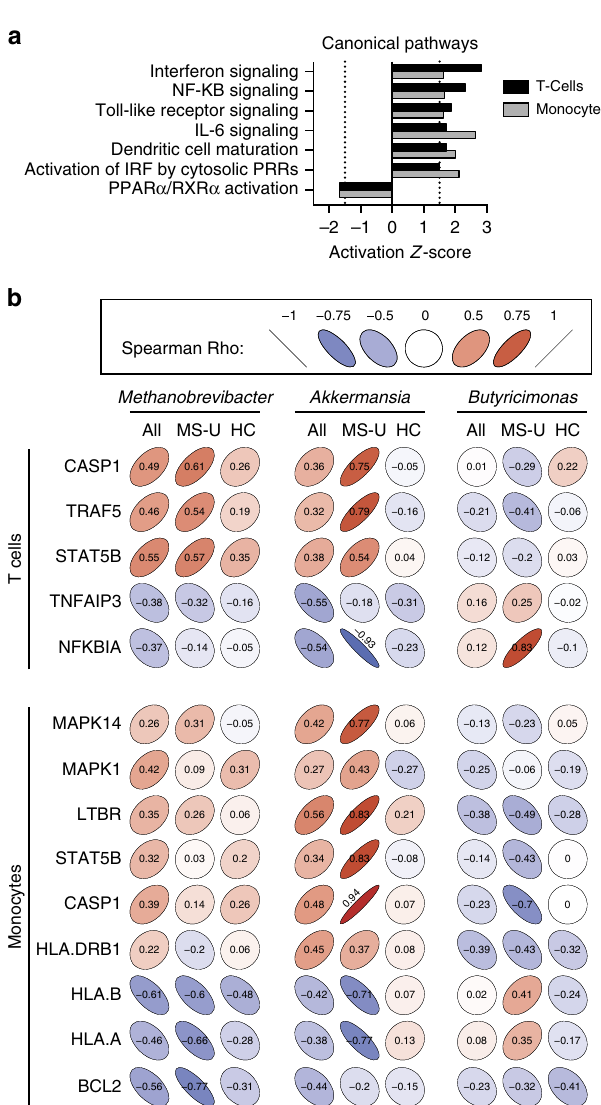
Figure 3 | Correlations between microbiota abundances and immune gene expression. ( a ) Gene expression was measured from circulating Tcells and monocytes by the Nanostring Immunology panel in MS patients ( n ¼ 18) and healthy controls ( n ¼ 18). ( a ) canonical pathways significantly altered in MS patients and healthy subjects with an activation z -score 4 |1.5| in both T cells (black bars) and monocytes (grey bars) identified by Ingenuity Pathway Analysis. ( b ) Altered gut microbiota abundances correlate with immune gene expression in MS patients. Spearman’s correlations ( s ) between the relative abundance of significantly altered microbes in subject groups and the relative expression of genes from identified canonical pathways significantly altered between healthy controls and untreated MS patients. Colour and slope of ellipse indicate magnitude of correlation, with s value superimposed on ellipse. Subject groups were either all MS patients and controls together (All), untreated MS patients alone (MS-U) or healthy controls alone